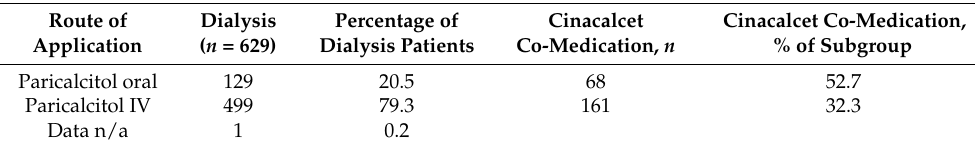
Table 10. Route of application at study start in the dialysis